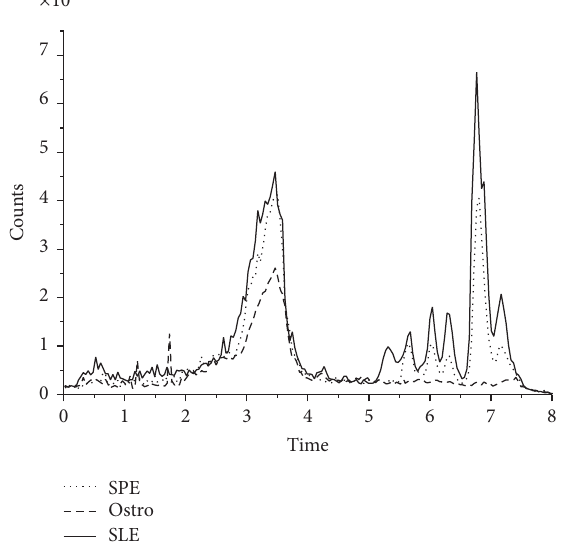
Figure 3: GPCho’s profiles of three different extraction methods.